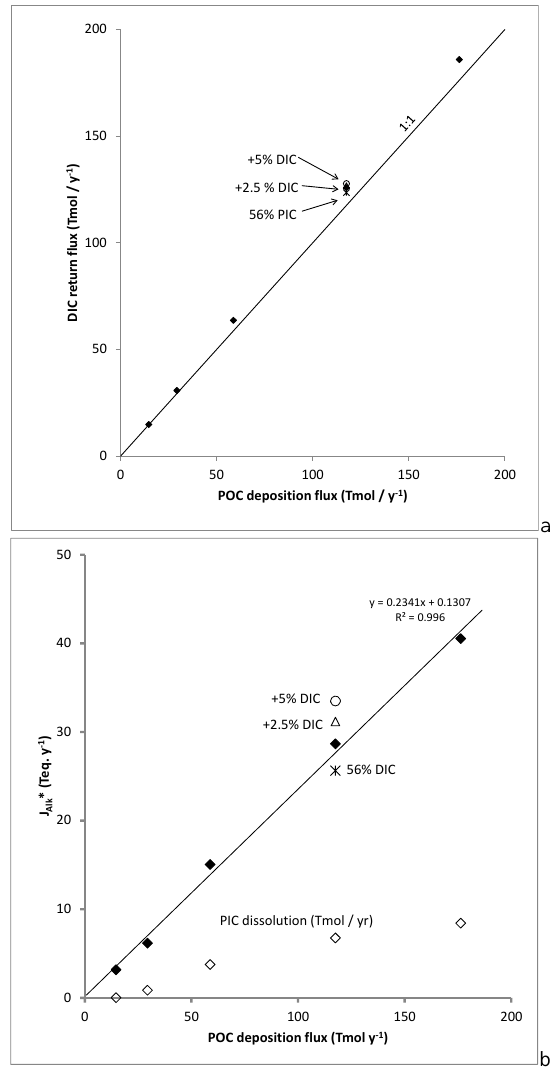
Fig. 9. Global coastal DIC return flux (a) , J Alk ∗ , and PIC dissolu- tion (b) , vs. POC deposition